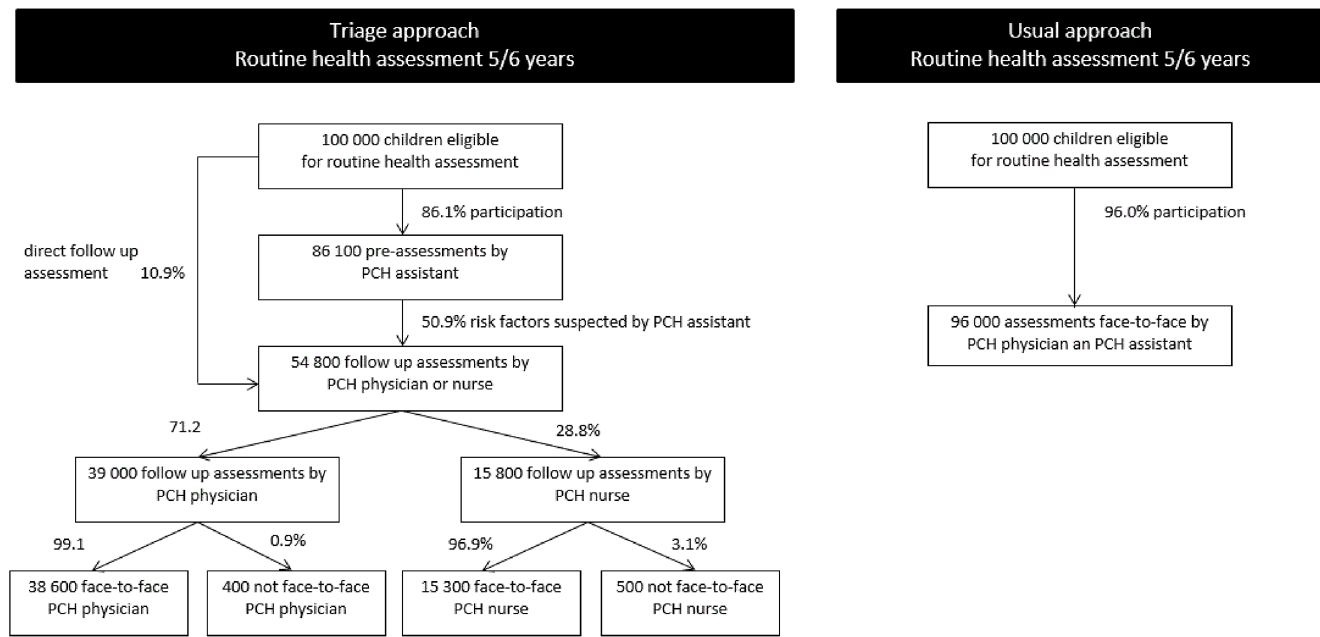
Fig 1. Flow chart outlining the assessments of a theoretical cohort of 100,000children aged 5–6 years, triage and usual approach.